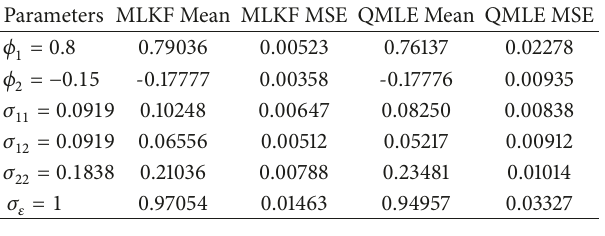
Table 4: Mean and MSE of estimated parameters for Example 2; 𝑛 = 200